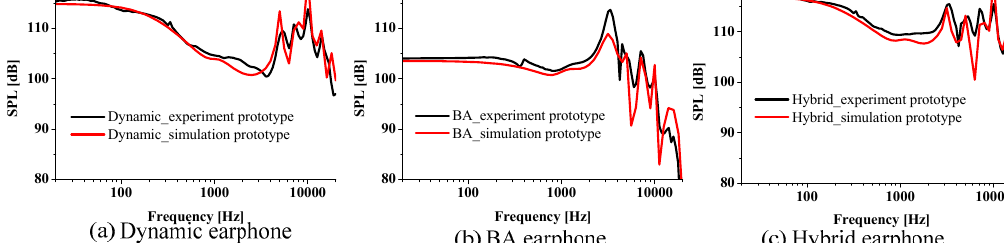
Table 2. Earphone definition and root-mean-square value of sound pressure level (SPL) deviation. Figure 12. Earphone sound pressure level (SPL) comparison between experiment and simulation.